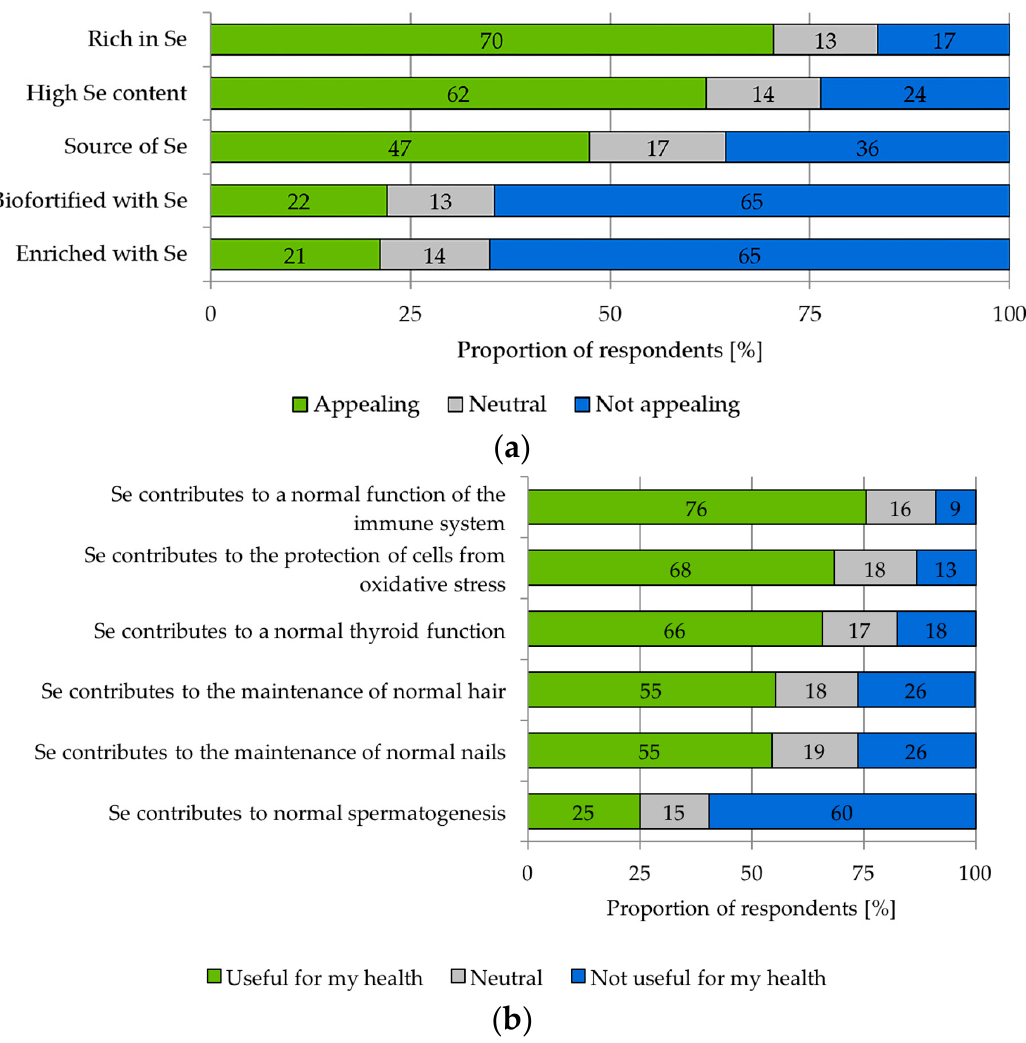
Figure 3. Acceptance of nutrition and health claims for Se-rich apples. Study participants were asked: ( a ) Please rate the following claims for apples with regard to the purchase of these fruits; possible scores ranged from one (“Not appealing at all”) to seen (“Very appealing”); pictures of real apples with a label on them were presented to the participants as stimuli (Figure A1), n = 321; ( b ) Please assess whether the following effects of an apple with higher Se content are personally useful to you; possible scores ranged from one (“Not useful for my health”) to seven (“Very useful for my health”), n = 312–316.